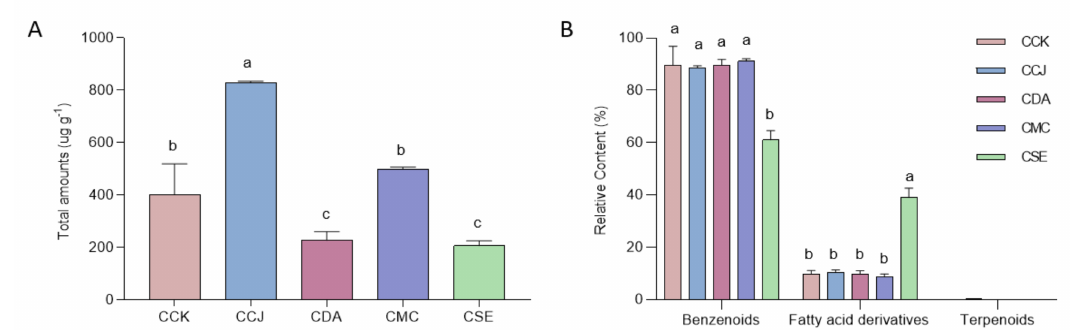
Figure 2. ( A ) Total amount ( µ g / g) of VOCs and ( B ) relative content (%) of VOCs classes in floral nectar of Castanea spp. The di ff erent letters on the bars indicate significant di ff erences among Castanea spp. based on One-way ANOVA with Duncan’s multiple range tests ( p < 0.05). Each value represents the mean ± SEM ( n = 3). Abbreviations; CCK, C. crenata (Korean cultivar ‘Mipung’); CCJ, C. crenata (Japanese cultivar ‘Ungi’); CDA, C. dentata (American chestnut); CMC, C. mollissima (Chinese chestnut); CSE, C. sativa (European chestnut).